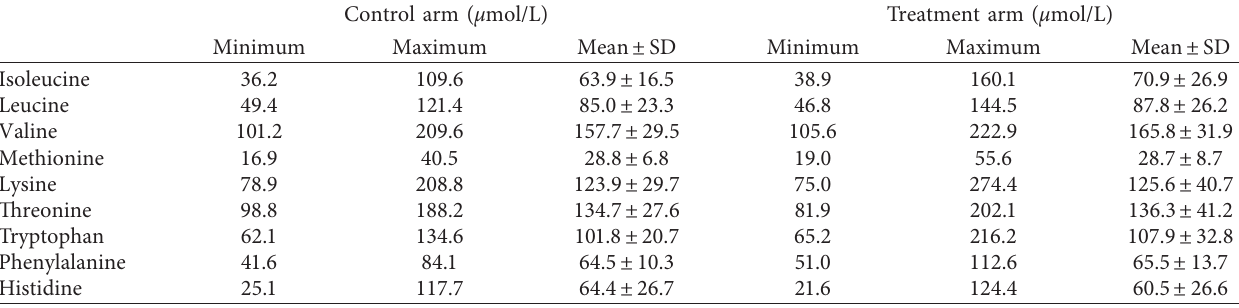
Table 2: Plasma levels of essential amino acids at baseline in the treatment and control